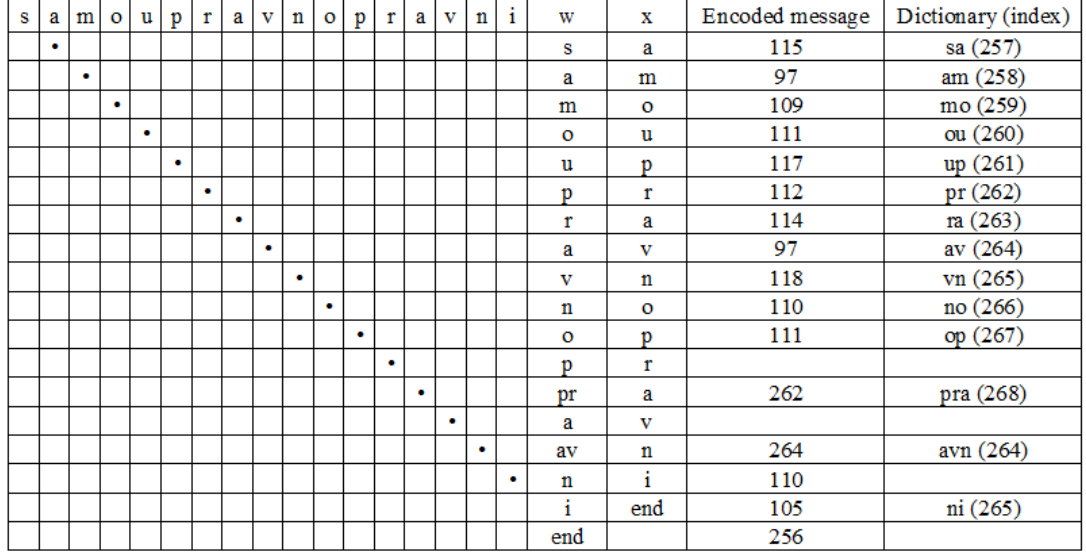
Figure 2. Lempel–Ziv–Welch (LZW) encoding of the word SAMOUPRAVNOPRAVNI.